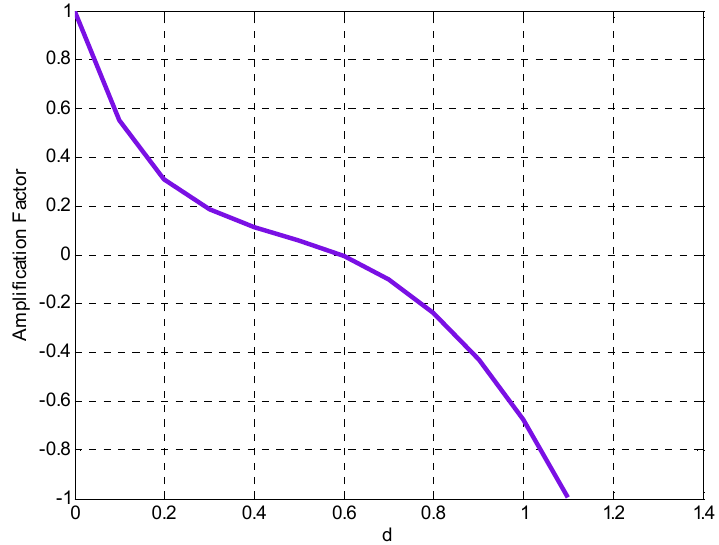
Figure 1. Amplification factor over diffusion number.